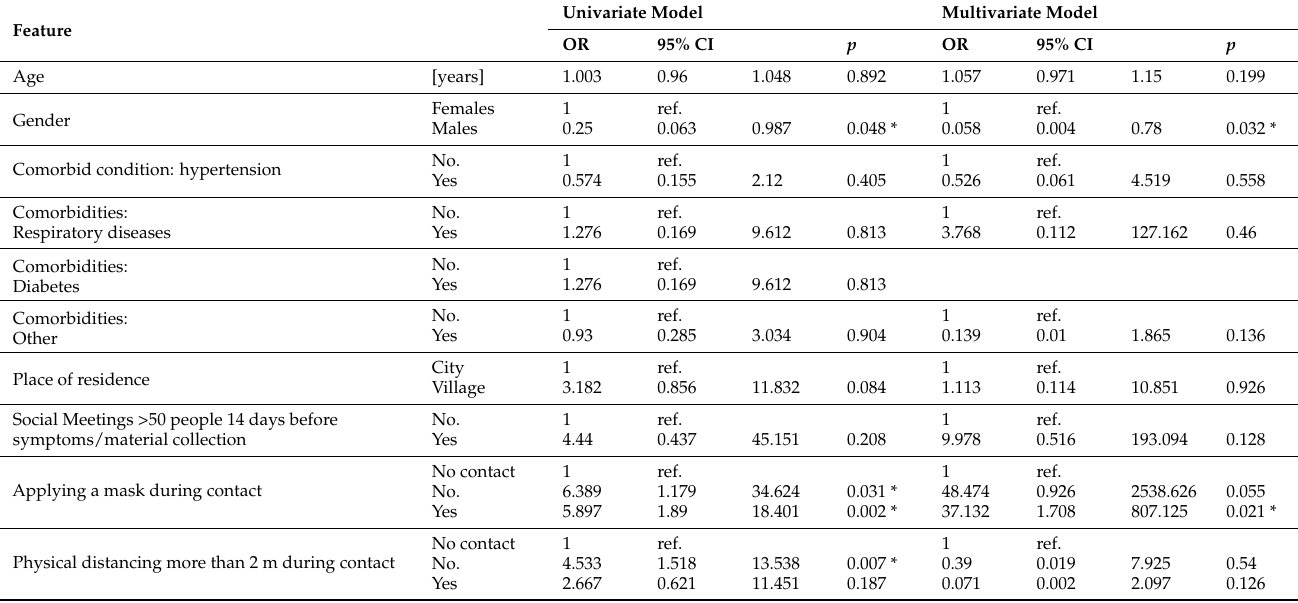
Table 6. Results of multivariate logistic regression for risk factors predicting symptomatic or severe covid-19. Feature